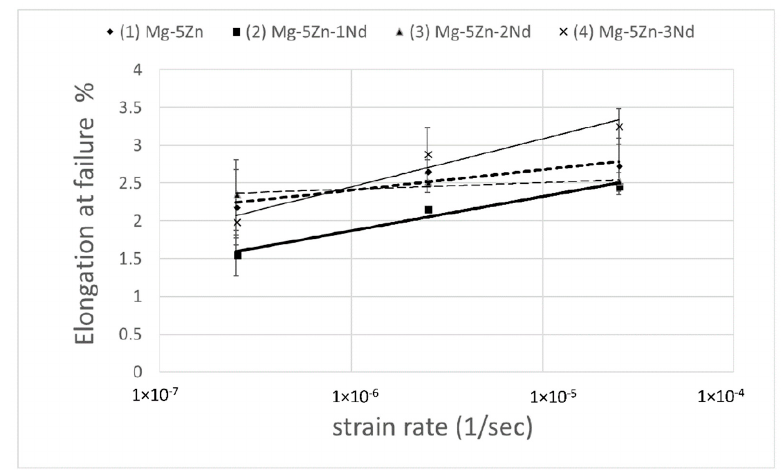
Figure 3. The ultimate tensile strength versus strain rate as obtained by the SSRT analysis for four different alloys.